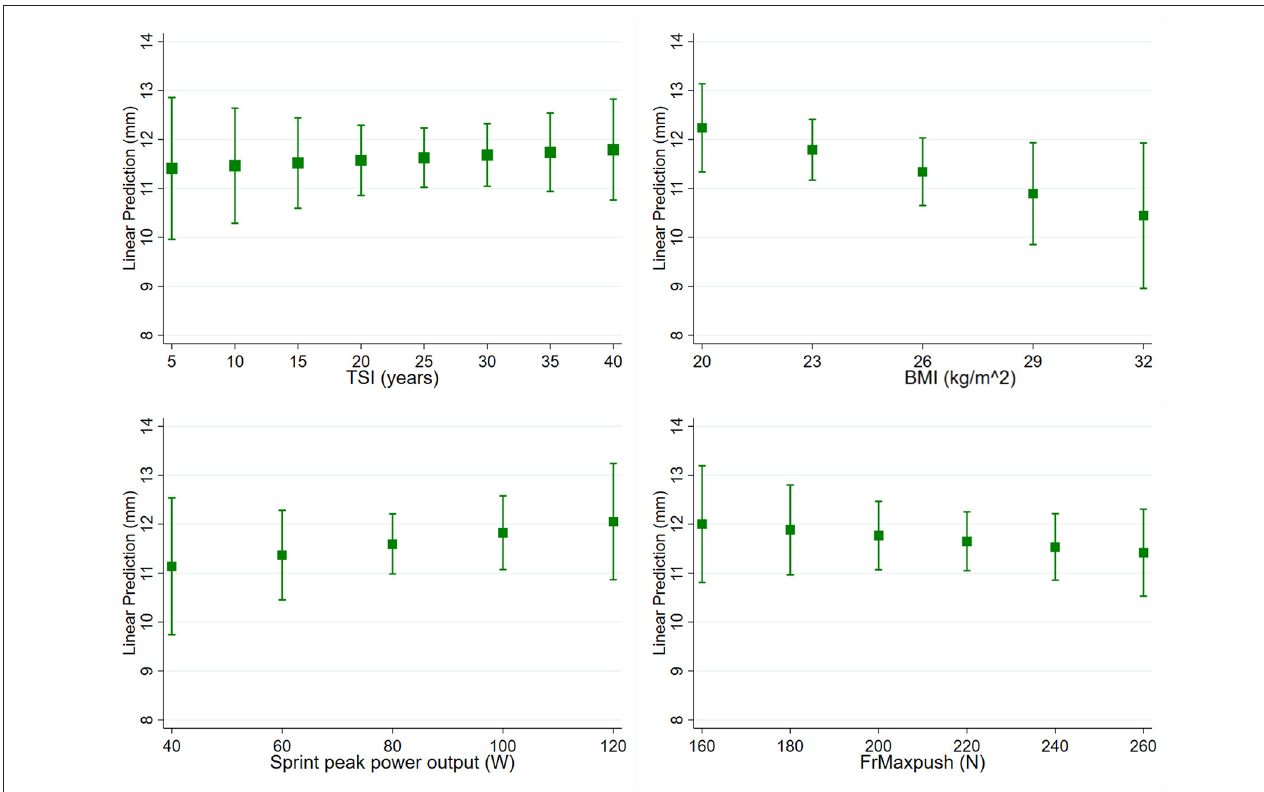
FIGURE 4 | Predictive margins with 95% confidence interval of acromiohumeral distance (AHD, mm) for continuous covariables time since injury [(TSI), p = 0.727], body mass index [(BMI), p = 0.083], sprint peak power output ( p = 0.941) and resultant force reached during maximum isometric forward pushes [(FrMaxpush), p =